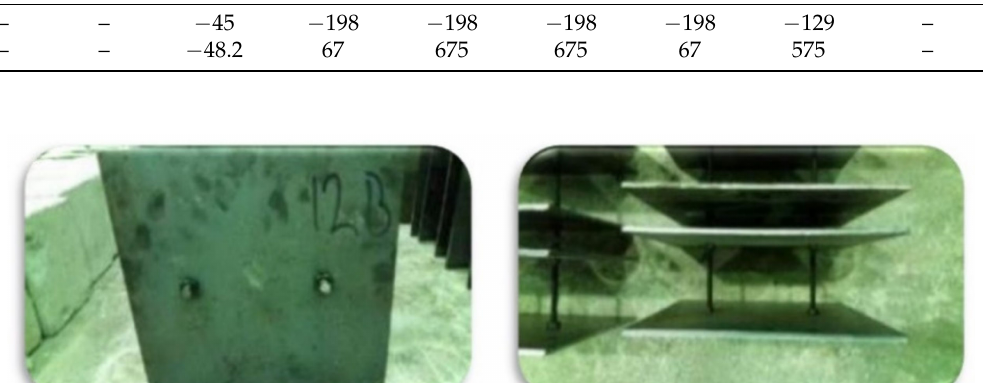
Figure 3. Reinforced plates with stud-bolt